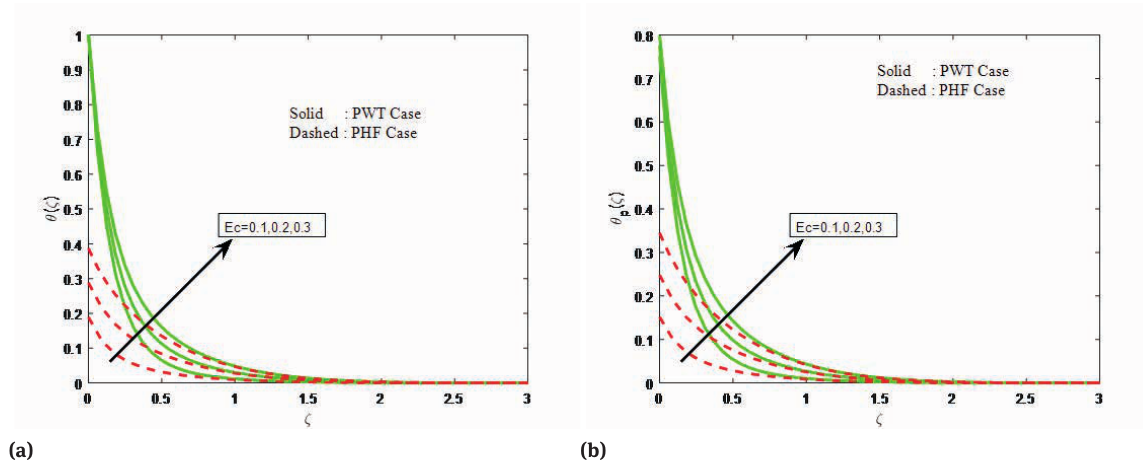
Fig. 8: a,b) Temperature profiles with varying Eckert number (Ec).